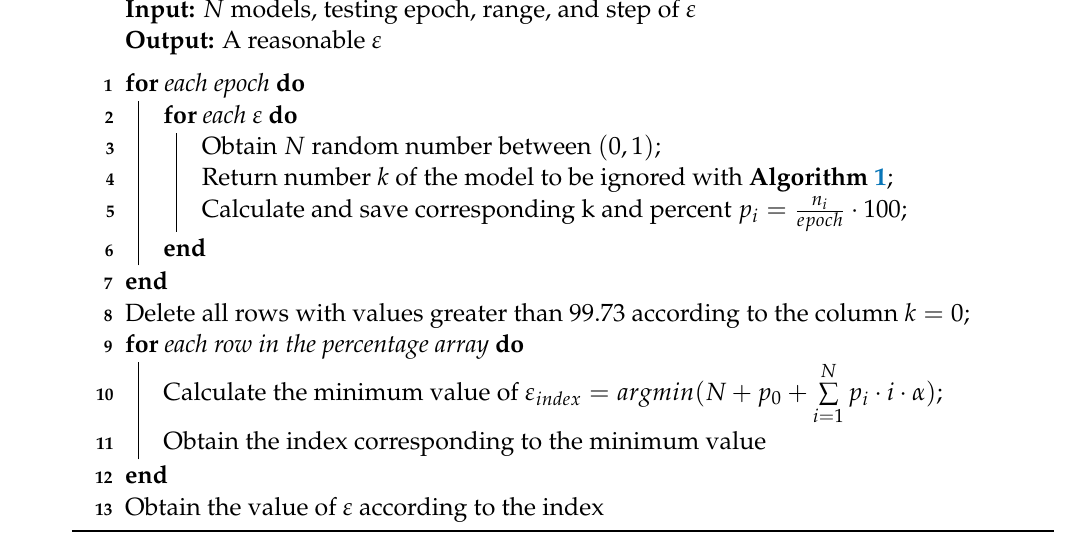
Table 1. Comparison of statistical properties between real data and generated data. The comparing items include the maximum, minimum, range, mean, median and standard deviation.